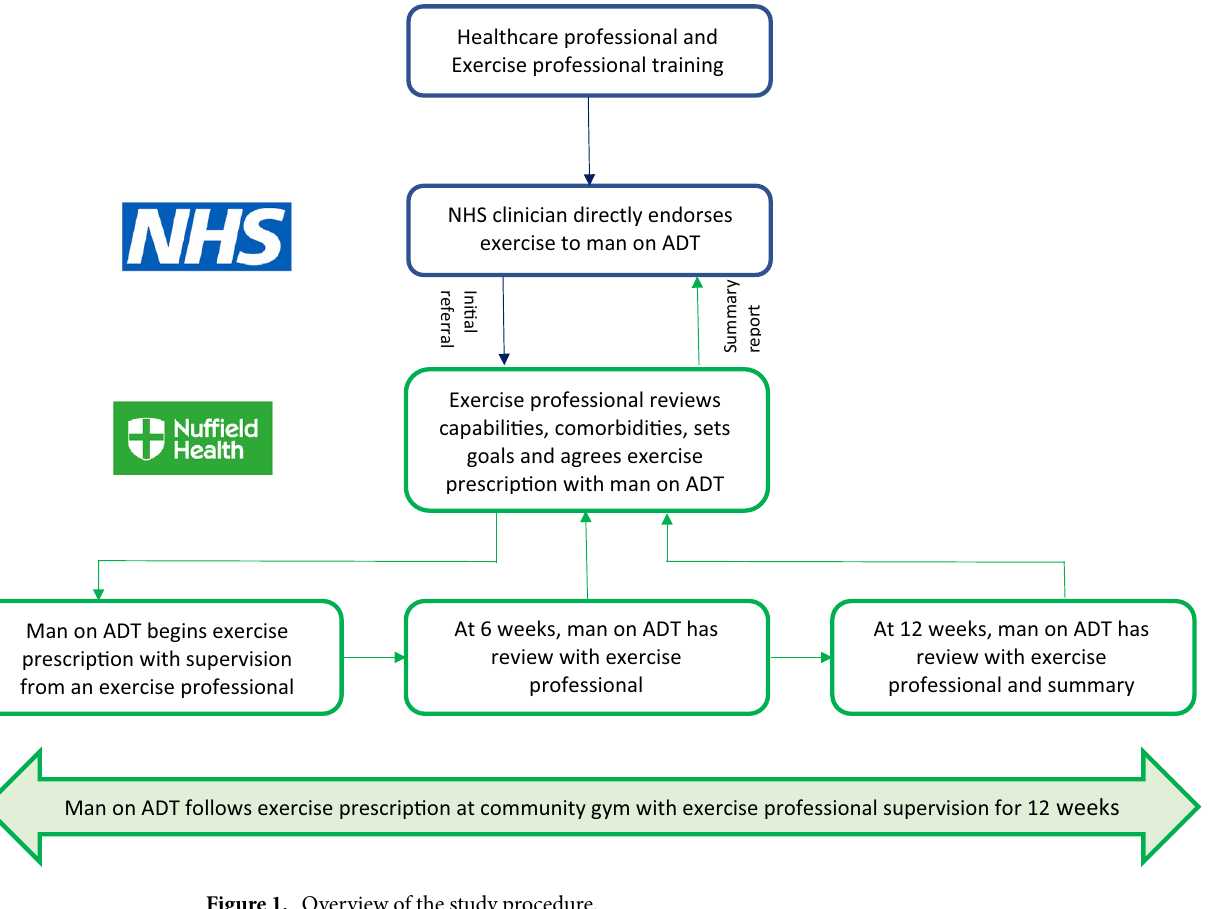
Figure 1. Overview of the study